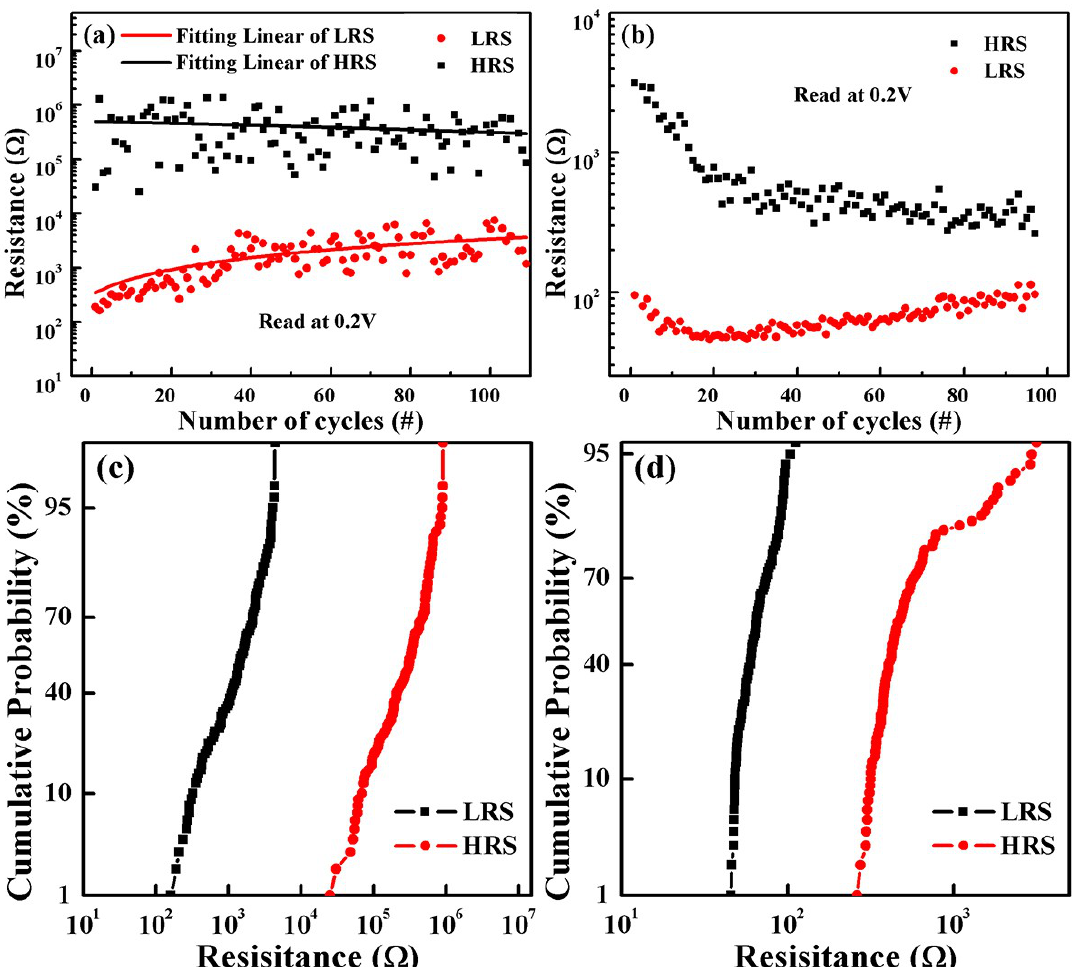
Figure 6. Endurance characteristics of ( a ) Au/HfO 2 /Pt/Ti/SiO 2 /Si and ( b ) Au/HfO 2 /Pt/mica RRAM devices at room temperature; ( c , d ) the cumulative probability plots of high resistance state and low resistance state for the two devices, respectively, at a reading voltage of 0.2 V.